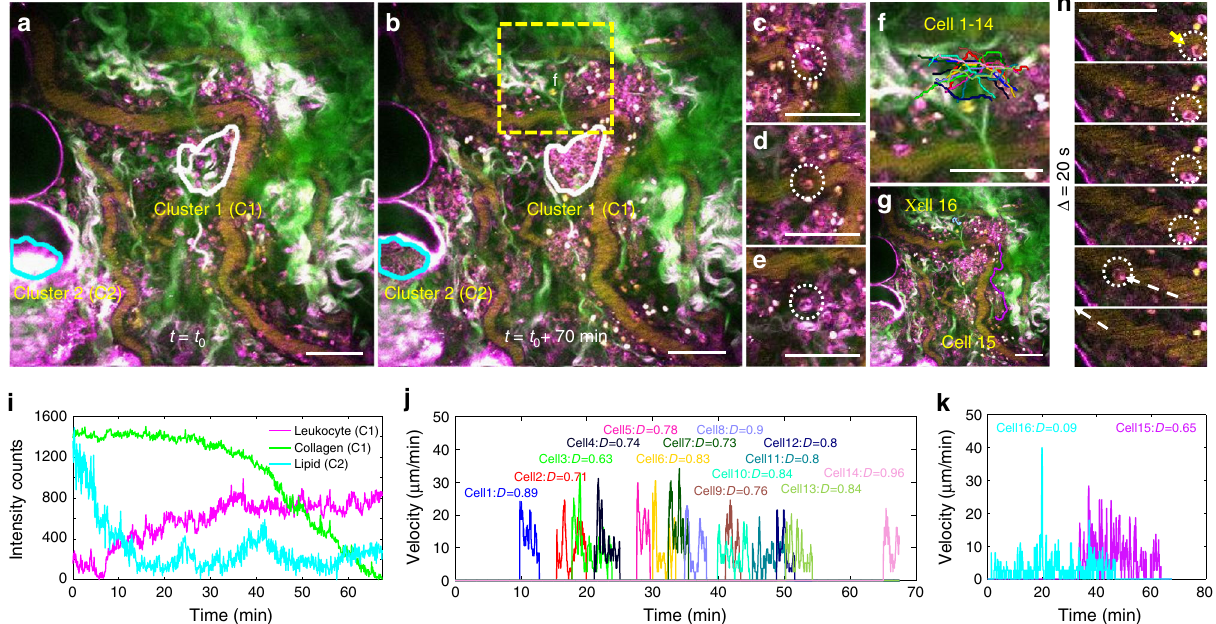
Fig. 4 Leukocyte-swarming visualized and characterized by SLAM microscopy. a , b Images acquired at the beginning and the end of the swarming, respectively. Collagen rearrangement was marked by the white boundary (Cluster 1, C1) while lipid interaction was marked by cyan boundary (Cluster 2, C2). c – e Zoomed-in images of multi-nucleated neutrophils. f Traces of Cells 1 – 14, which were tracked to travel via similar routes to the same cluster at different time points, as shown in the velocity map j . g Traces of Cells 15 – 16, which were both tracked for at least 30 min and exhibited different behavior, with Cell 15 migrating towards the cluster with high speed and high directionality throughout the entire time course and Cell 11 mostly making random walk, as shown in the corresponding velocity map k . h Leukocytes leaving the site (Cells 17 – 18 in Supplementary Movie 5). The series of snapshots were taken every 2 s and shown for every 20 s. The fi rst three snapshots showed the deformation of the leukocyte, changing from a round shape to a stretched cell elongated along the direction of travel, which typically precedes the acceleration process shown in the last three snapshots. i Quanti fi cation of collagen clearance, cell accumulation, and lipid deformation within the marked clusters in a and b (C1 and C2). j , k Velocity and directionality map of Cells 1 – 16. The color of the curves matches the color of the traces in f and g and Supplementary Movie 5. D directionality. Scale bar: 50 µ